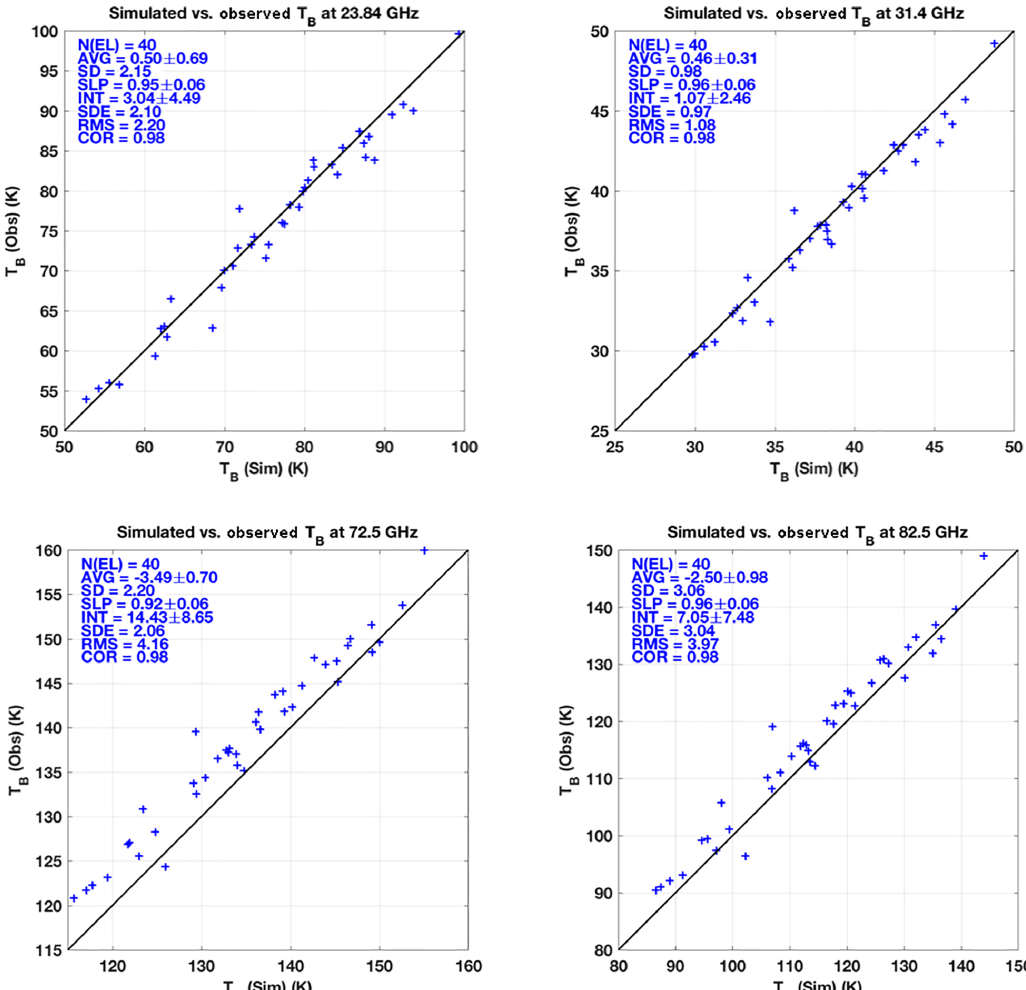
Figure 4. Scatter of simulated vs. observed T B at 35.3 ◦ elevation for four channels of LWP-U72-82. Locations of radiometer and radiosondes are as in Fig. 3. The absorption model of Rosenkranz (2017) has been used. Each panel reports the number of elements ( N (EL)), the average difference (AVG), the standard deviation (SD), the slope (SLP) and intercept (INT) of a linear fit, the standard error (SDE), the root-mean square (rms), and correlation coefficient (COR); 95% confidence intervals are given for AVG, SLP, and INT. Units for AVG, SD, SDE, and rms are in